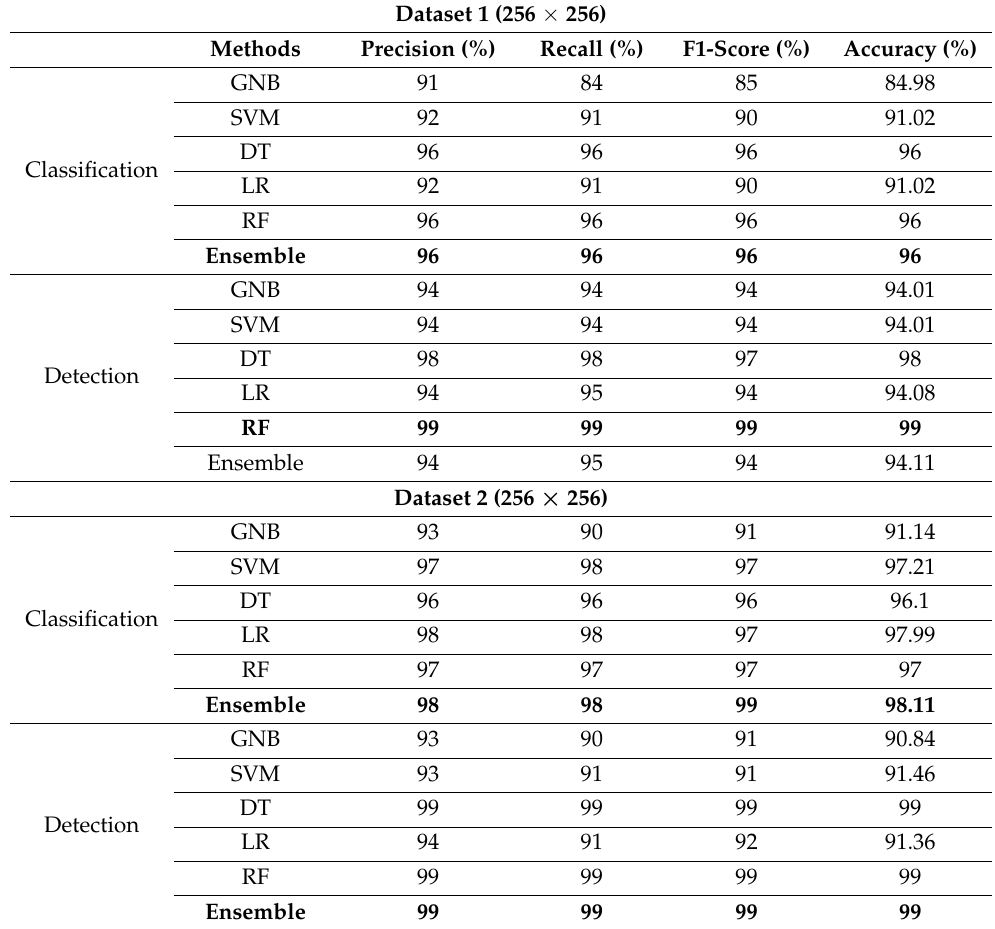
Table 5. Performance comparisons for malware classification and detection using both datasets with 256 × 256.